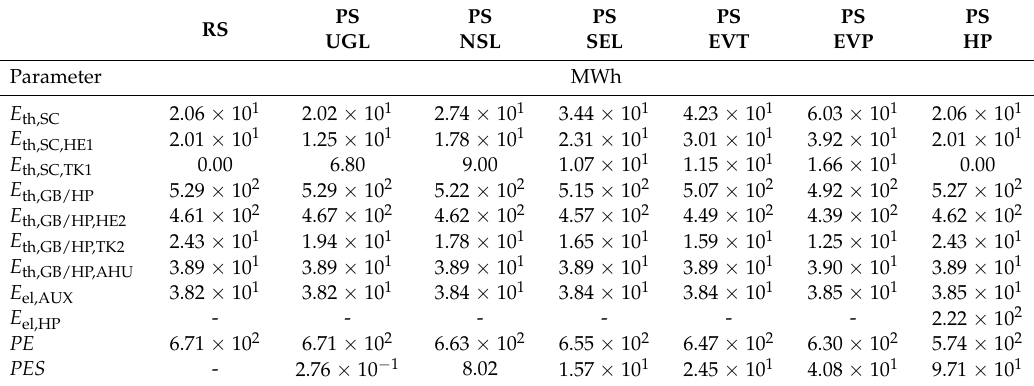
Table 7. Main thermal, electrical and primary energies of the system, yearly